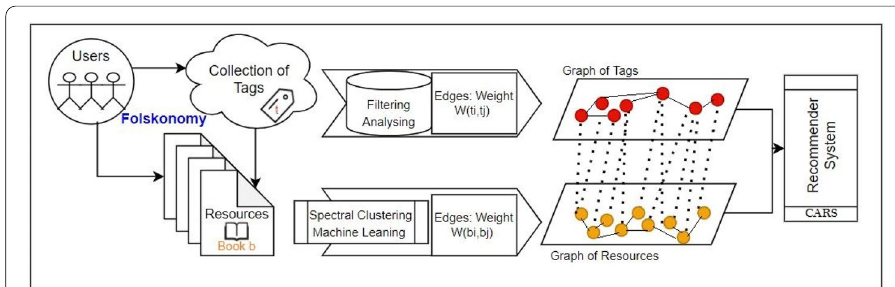
Fig. 1 Modeling folksonomy relationship into a semantic graph-based CARS of books